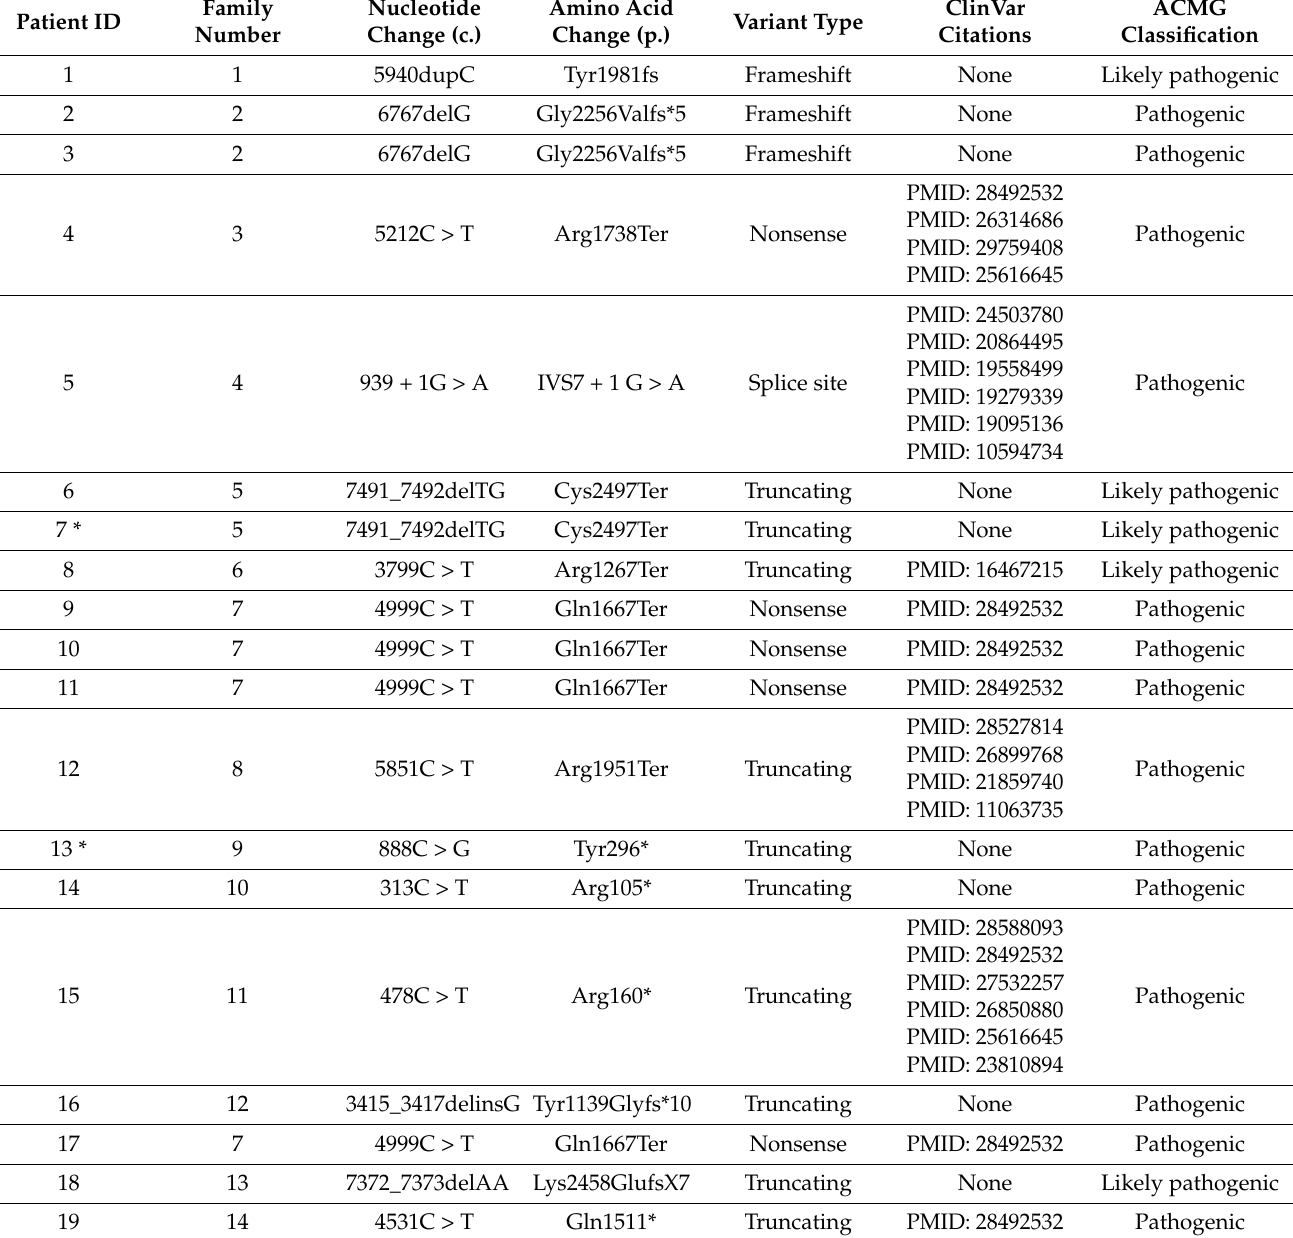
Table 2. Pathogenic and likely pathogenic variants in the desmoplakin gene ( DSP ) in 19 patients. * Patient ID 7 also carried a pathogenic truncating variant (c.629_631delAGA, p.Lys210del) in TNNT2 (cardiac troponin T). Patient ID 13 also carried an in-frame deletion (exons 49–51) in DMD (dys- trophin). Classifications were based on interpretations from Clinical Laboratory Improvement Amendments-certified laboratories and confirmed by institutional genetic counselors. Abbreviations: ID = identifier; ACMG = American College of Medical Genetics and